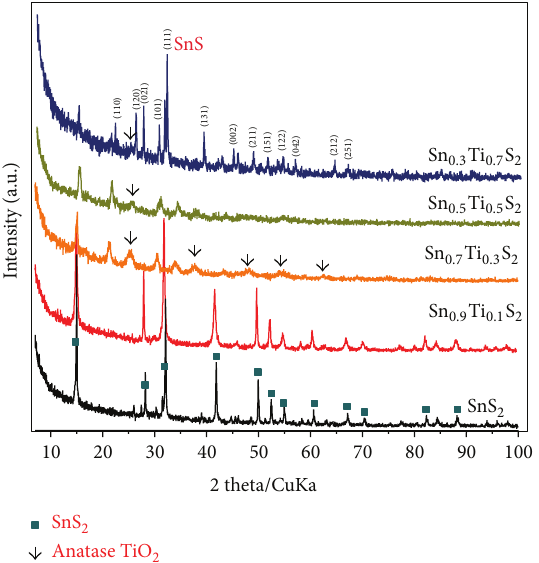
Figure 2: XRD patterns of the as-synthesized SnS 2 and Sn 1−